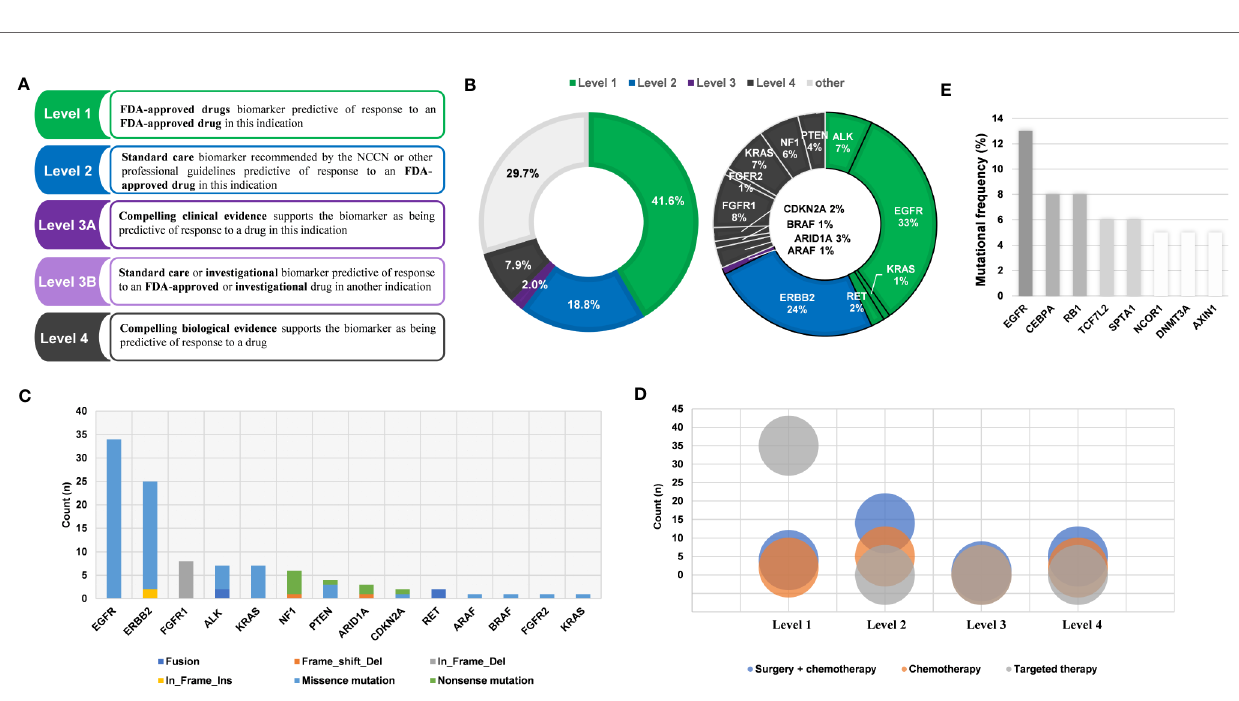
FIGURE 4 | Clinical actionable mutations and their clinical evidence. (A) OncoKB levels of evidence. (B) Samples were divided into different grades according to mutations (left). Mutated genes in different grades (right). (C) Mutation types in actionable alterations. (D) Different treatment means in different grades. (E) The most frequently mutated genes in patients without actionable